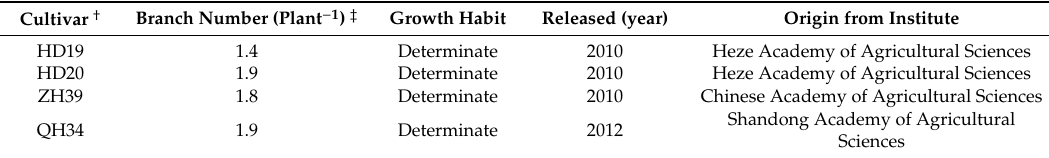
Table 1. Information on the experimental cultivars.